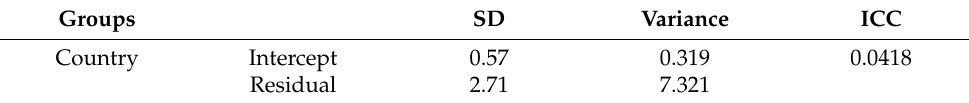
Table 10. Non-consensual sexting: estimates of random component.